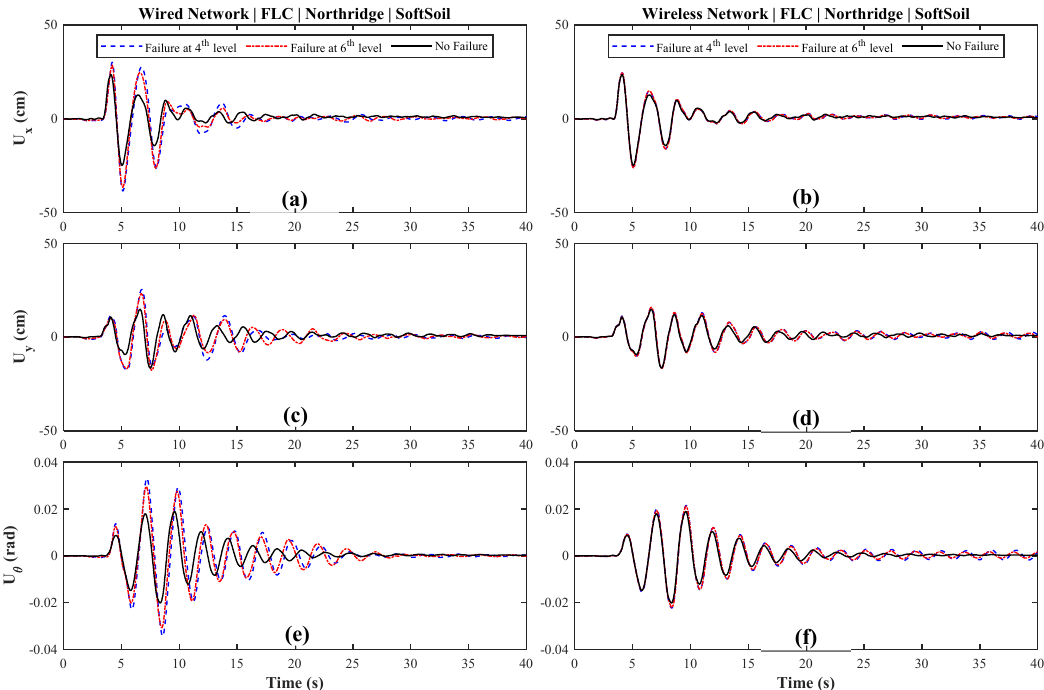
Figure 15. Wireless vs. wired sensor network in case of power or signal line failure (Case I) in the x -direction, ( a ) and ( b ), in the y -direction, ( c ) and ( d ), and in the θ -direction, ( e ) and ( f ).